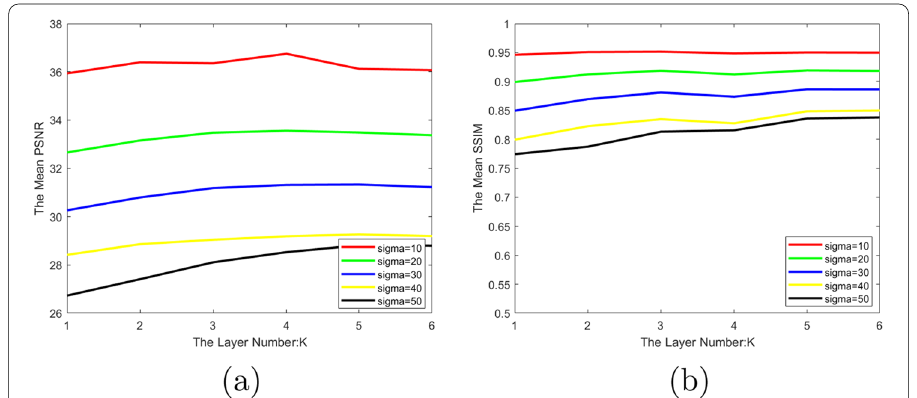
Fig. 2 From above to bottom: a the average PSNR (dB) of different number of layers, b the average SSIM of different number of